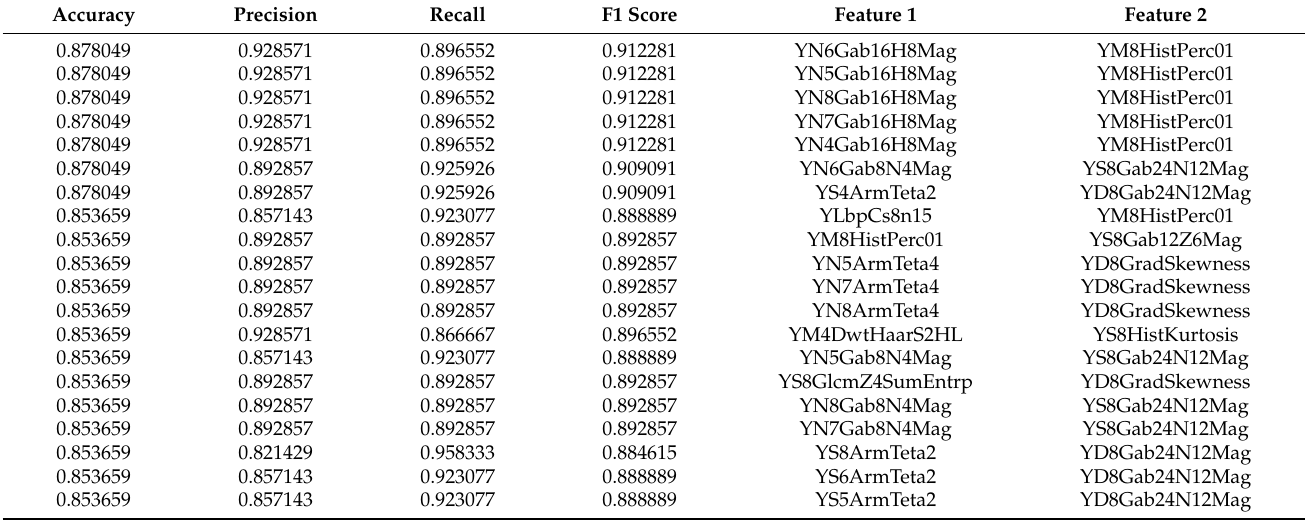
Table 3. The best 20 pairs of features when the whole prostate region is used to calculate features.